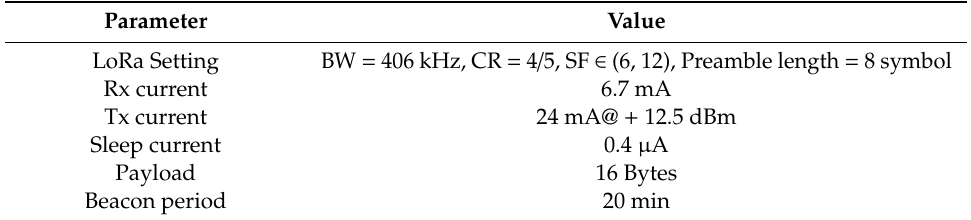
Table 4. Simulation